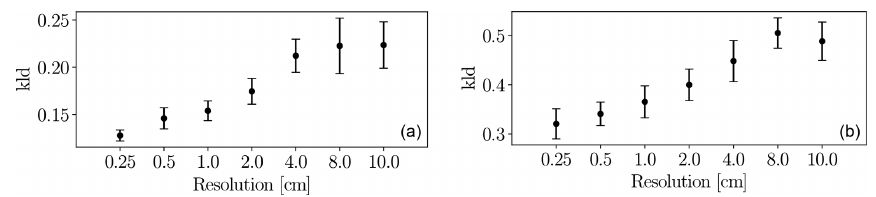
Figure E1. Resolution study for GRAINet regressing the relative frequency distribution (a) and regressing the relative volume distribution (b) by optimizing the KLD loss.